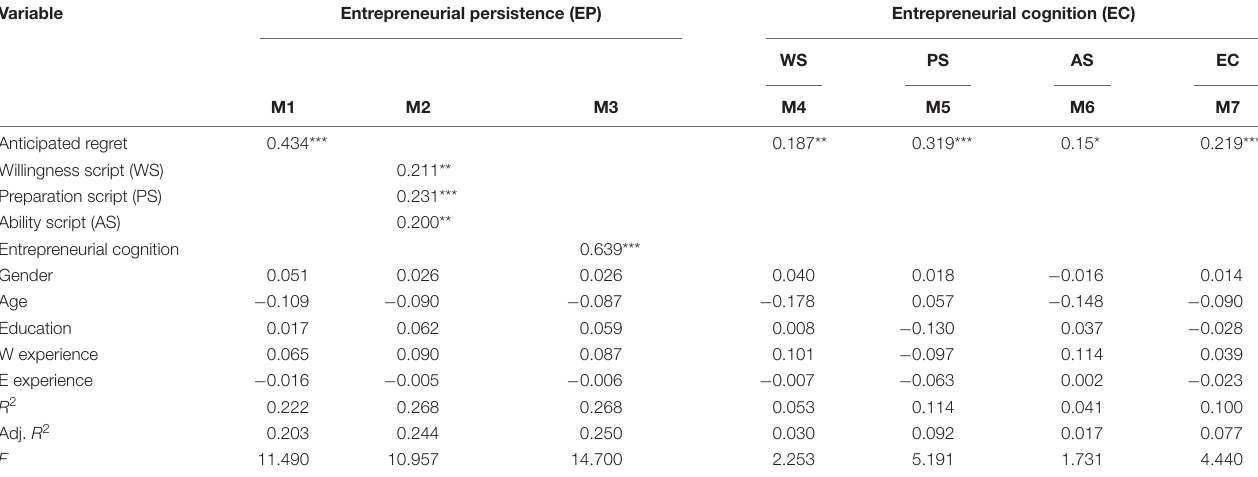
TABLE 3 | Regression results of anticipated regret, entrepreneurial cognition, and entrepreneurial persistence. Variable